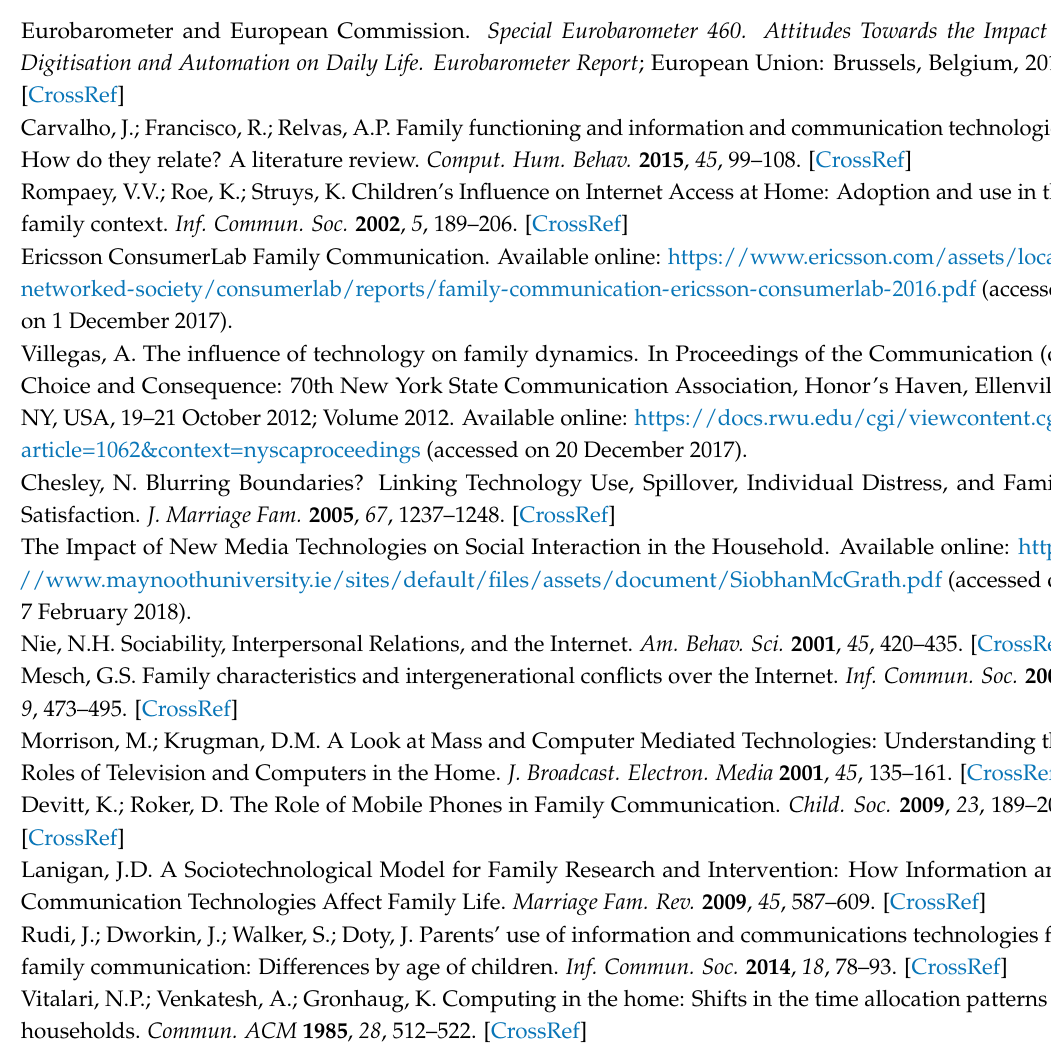
Figure A2. User experience testing and survey.